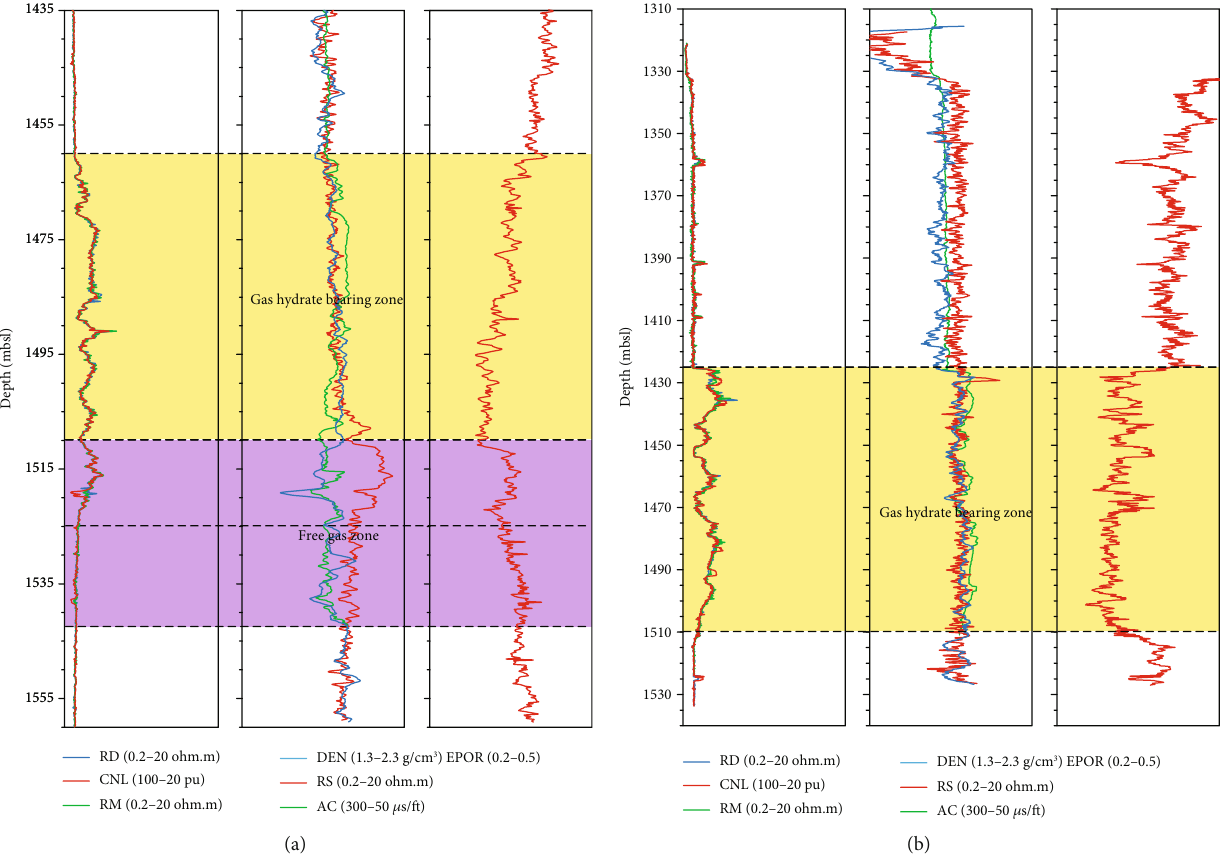
Figure 5: Comprehensive log interpretation graphs of the A-well and